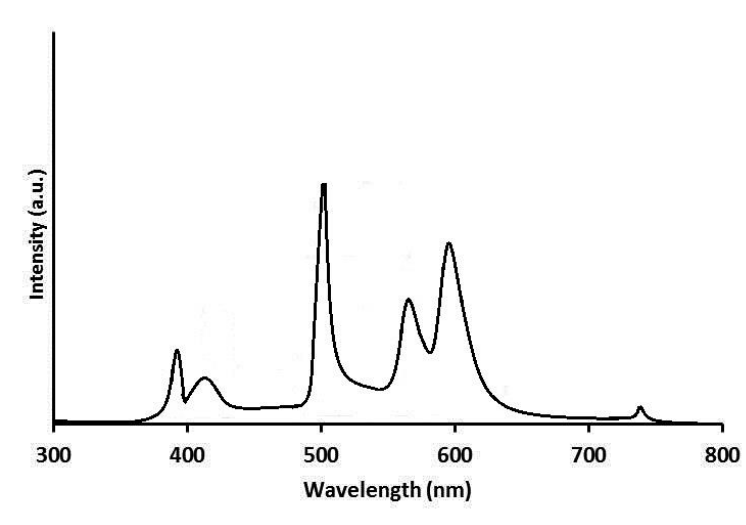
Fig.7. The spectra of the lamp used for catalytic Figure 7 . The spectra of the lamp used for catalytic process lamp used for catalytic process.